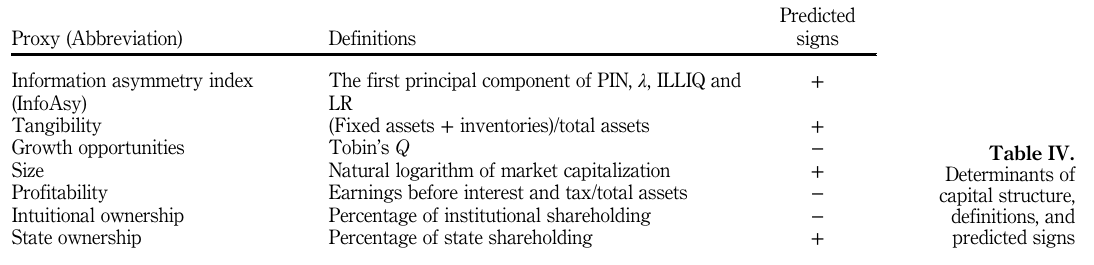
Table IV. Determinants